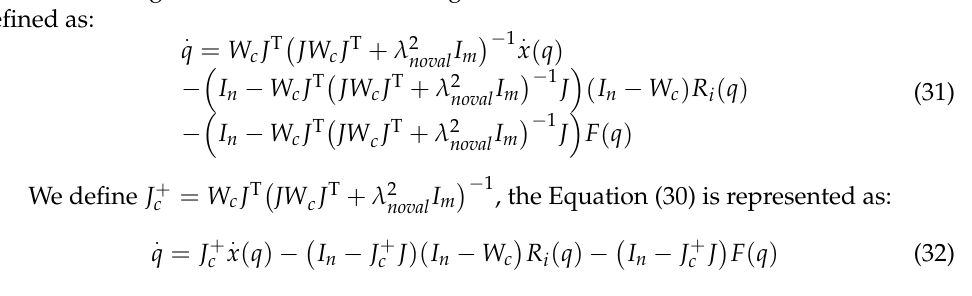
Figure 4. The shape of the function f ( d ( σ )) is set using two parameters: σ b and σ b . The example shows σ b = 0.2 .